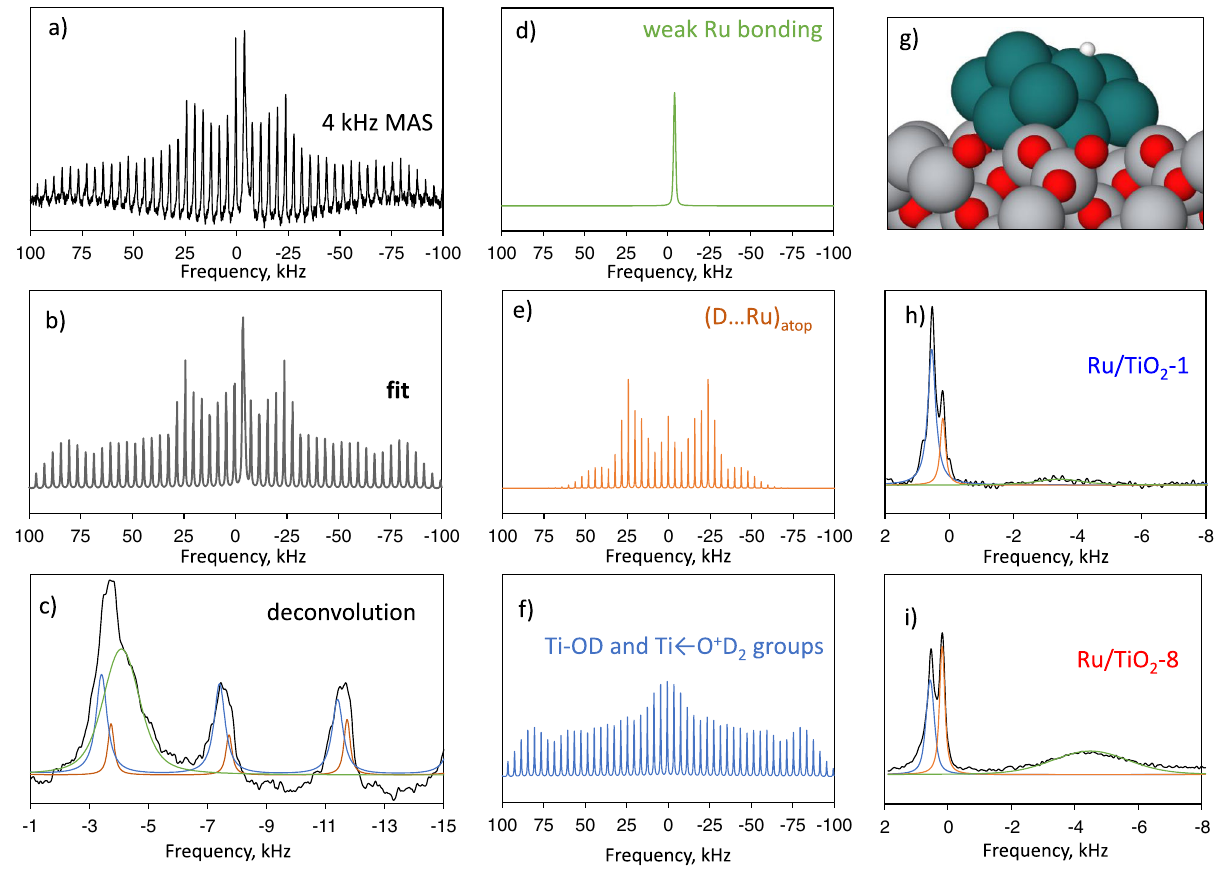
Fig.2|HydrogenchemisorptiononRu/TiO 2 .a Solid-state 2 HMASNMRspectraof Ru/TiO 2 -8measuredat4kHzofspinning. b Fittingofexperimentalspectra. c Zoom in low-frequencies alongside three components used for fi tting, resolved via deconvolution. d – f Deconvoluted signals of weakly bonded D on Ru ( d ), strongly